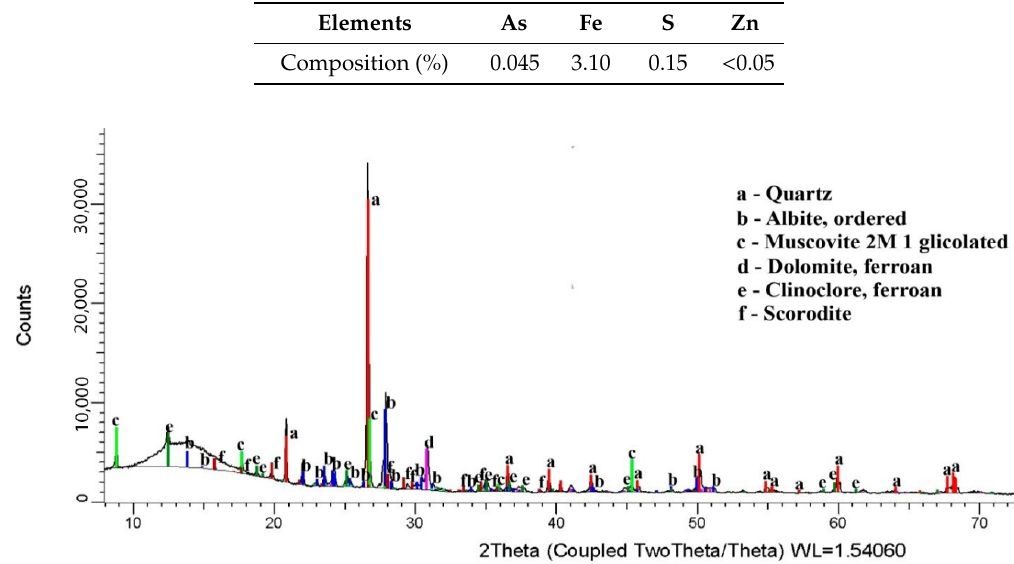
Figure 1. XRD pattern of mine tailings before bioleaching.